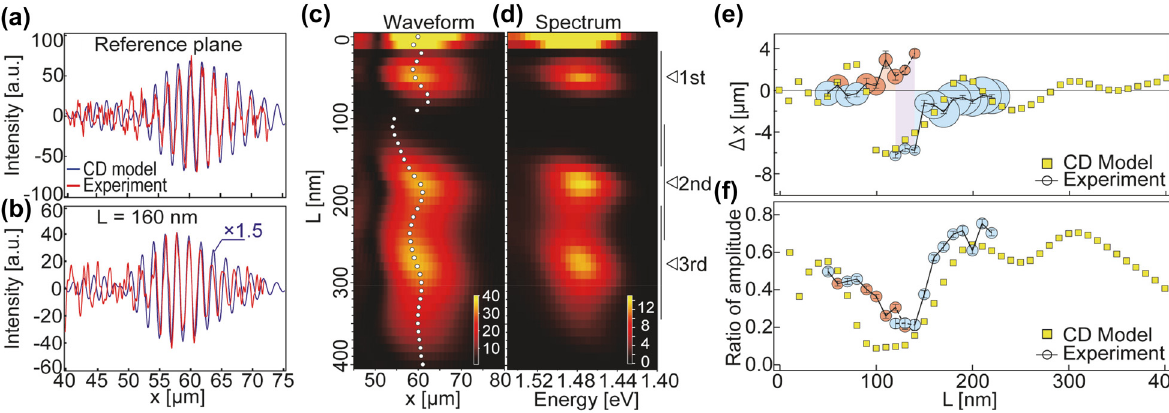
Figure 4: Peak shift, spectral modulation, and amplitude attenuation of SPP WP examined by CD model and experiment. The beat patterns calculated by the CD model for (a) the reference plane and (b) the cavity plane containing an MIM-NC with L = 160 nm (blue lines) and their corresponding experimental results obtained from the time-resolved micrographs (red lines) are shown. The average delay time ( τ d ) was 185 fs, at which the intensity peak of a beat pattern in the reference plane reached x = 60 μ m in both the calculations and experiments. (c) Two-dimensional plots of envelope of beat pattern calculated by CD model as function of length of cavity ( L ) and x . The white circles indicate the peak positions of each envelope. (d) Two-dimensional plots of spectra of transmitted SPP WPs calculated by CD model as function of L and energy. (e) Extent of peak shift of beat pattern in cavity plane compared with that in reference plane. The yellow squares and colored circles show the peak shifts determined by the CD model and experiment, respectively. The red and blue circles indicate the forward and rearward peak shifts, respectively. The diameter of a circle indicates the amplitude of a beat pattern. For L = 120 – 140 nm (purple-colored region), peak shifts are indicated by two circles re fl ecting the double-peak feature (Figure 2(d)) of an experimental beat pattern. (f) Ratio of maximum amplitude of beat pattern in cavity plane to that in reference plane plotted as function of L . The yellow squares and colored circles show the results of the CD model and experiment,